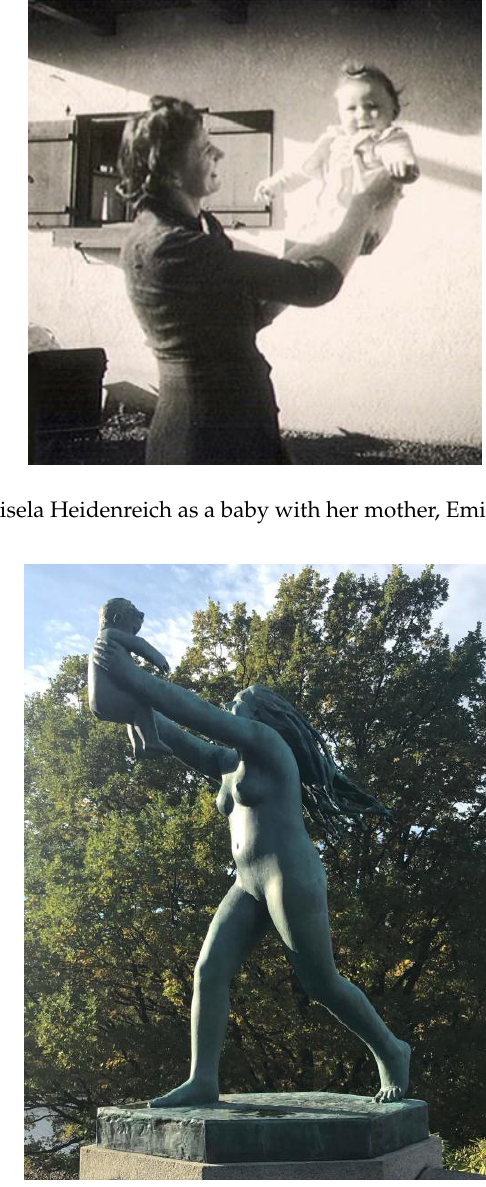
Figure 2. Mother and Child by Gustav Vigeland, Vigeland Sculpture Park inside Frogner Park in Oslo, Norway © Amila Becirbegovic.